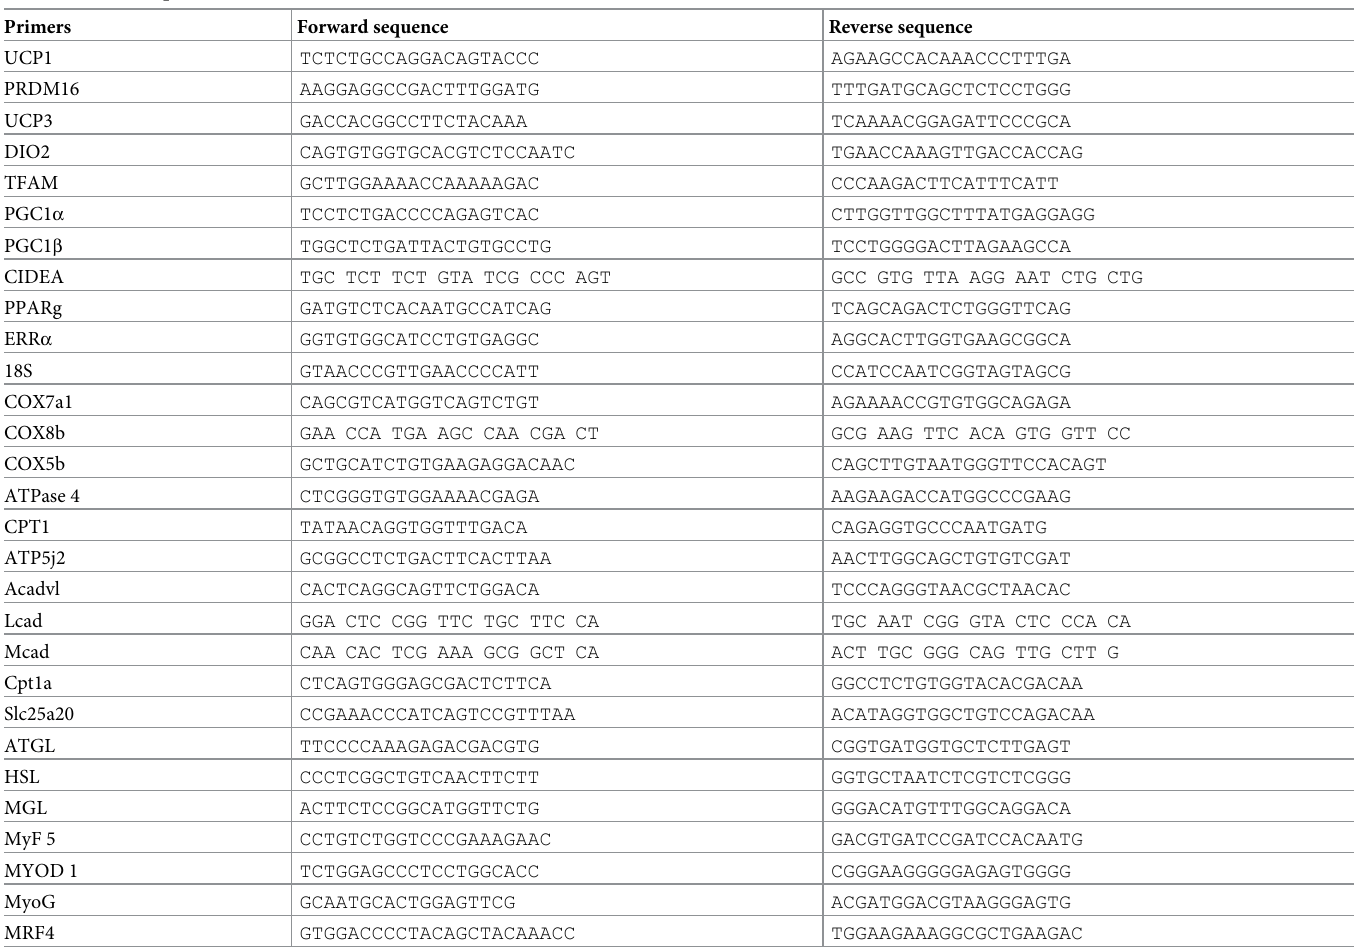
Table 1. Primer sequences for real-time